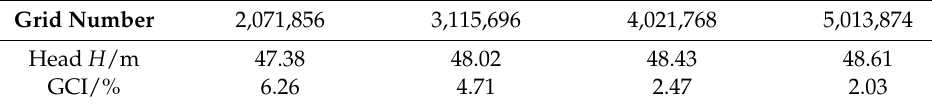
Figure 2. Computational domain and grid meshing. Table 2. GCI test on grids.